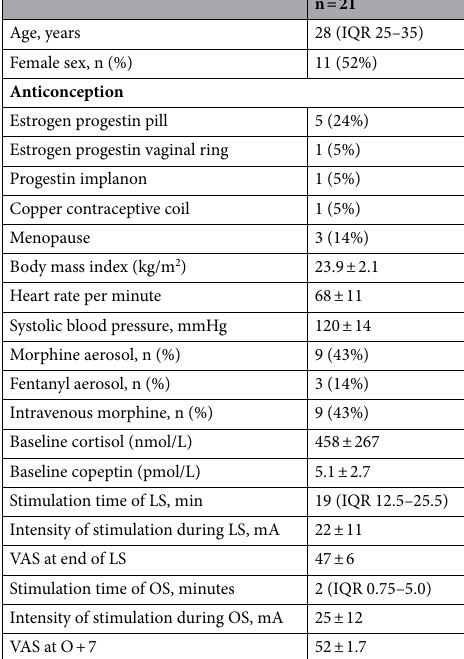
Table 1. Characteristics of subjects and of nociceptive reflex. n = 21 includes only subjects who completed all test sessions and had a complete data set available. Normally distributed data is shown as mean ± SD, otherwise as median (IQR). LS learning session, OS opioid session, VAS visual analog pain scale rating from 0 to 100, 0 meaning no pain and 100 the worst imaginable